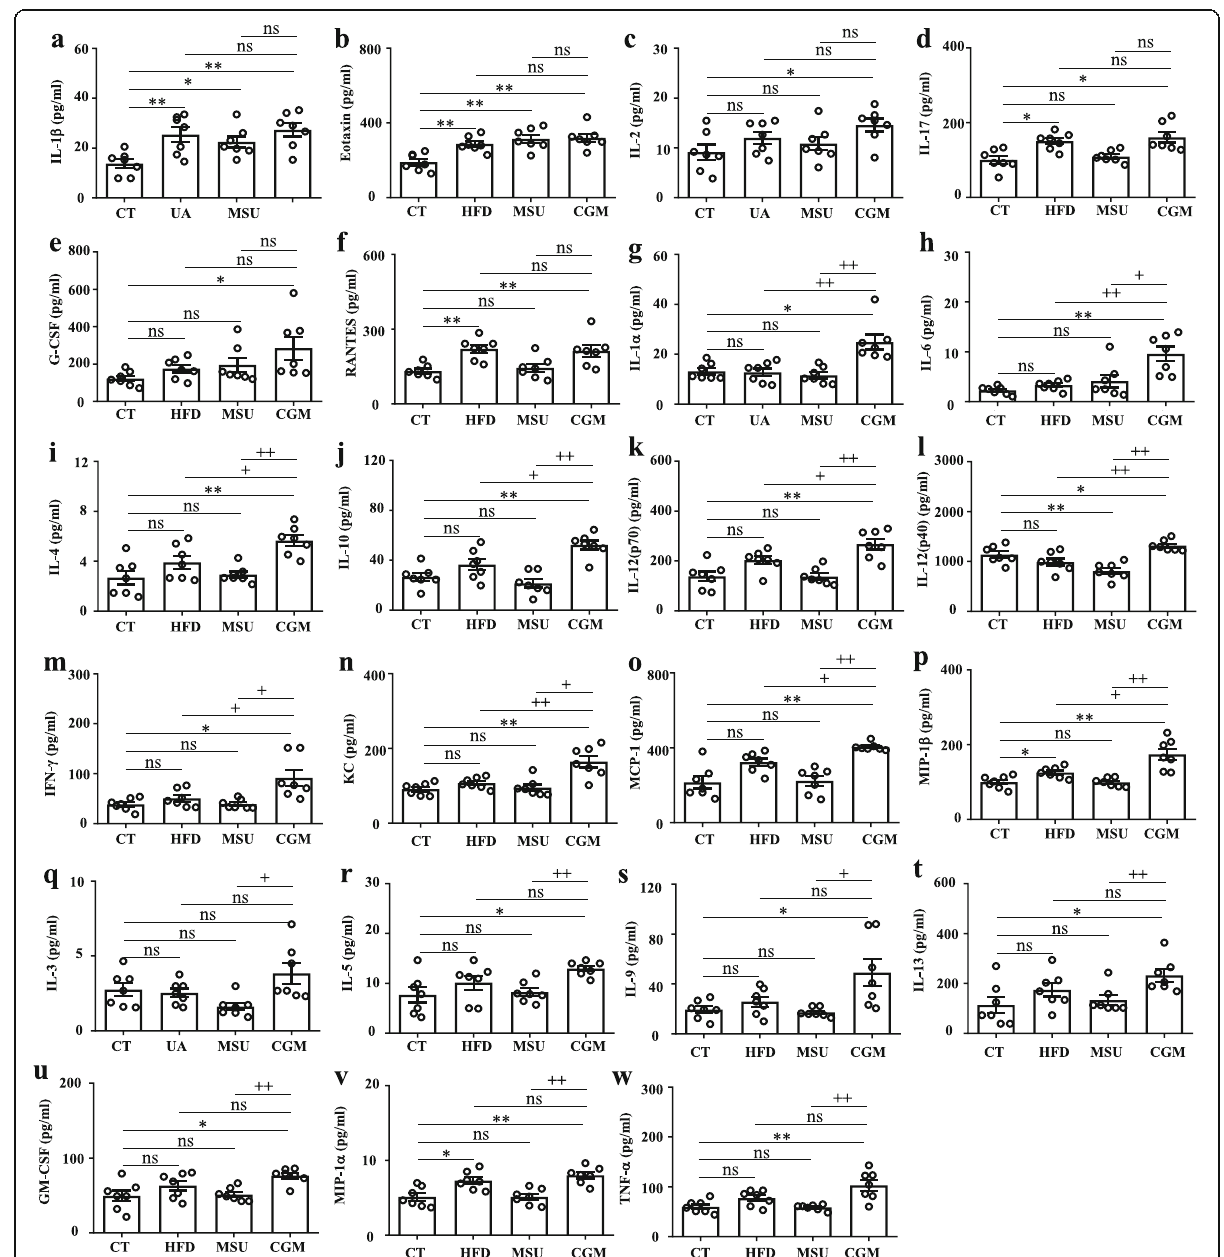
Fig. 3 Serum proinflammatory cytokines levels of mice in the four groups. IL-1 β ( a ); eotaxin ( b ); IL-2 ( c ); IL-17 ( d ); G-CSF ( e ); RANTES ( f ); IL-1 α ( g ); IL-6 ( h ); IL-4 ( i ); IL-10 ( j ); IL-12(p70) ( k ); IL-12(p40) ( l ); IFN- γ ( m ); KC ( n ); MCP-1 ( o ); MIP-1 β ( p ); IL-3 ( q ); IL-5 ( r ); IL-9 ( s ); IL-13 ( t ); GM-CSF ( u ); MIP-1 α ( v ) and TNF- α ( w ). “ ns ” represents not significant; “ * ” represents p < 0.05 in comparison with CT; and “ ** ” represents p < 0.01 in comparison with CT; “ + ” represents p < 0.05 in comparison with CGM; and “ ++ ” represents p < 0.01 in comparison with CGM. CT: control group; HFD: hyperuricaemia model; MSU: acute gout model; CGM: compound gout